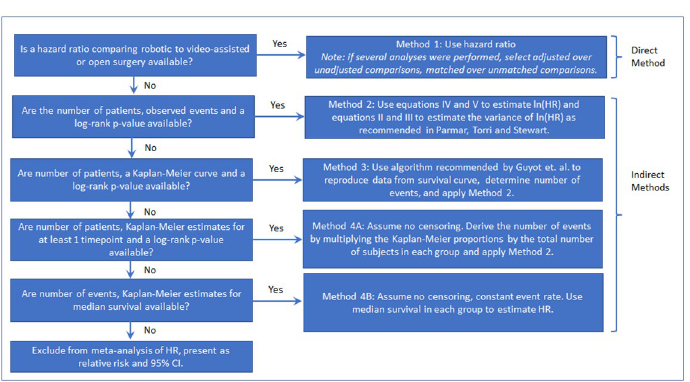
Fig 1. Decision tree for hazard ratio extraction: Flow chart to determine which hazard ratio estimate to use based on data provided in manuscript.